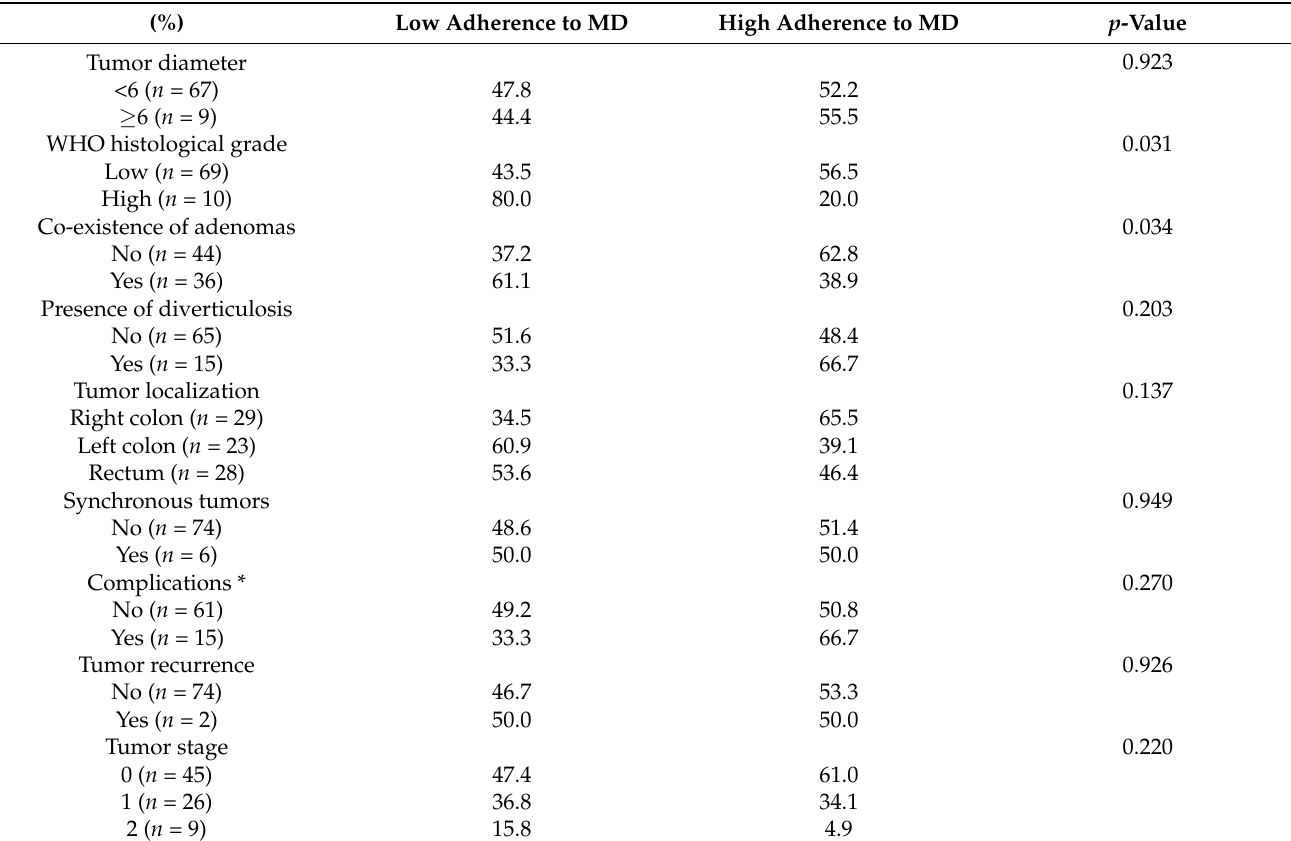
Table 2. Relationship between patients’ adherence to the Mediterranean diet and factors related to their CRC tumor.